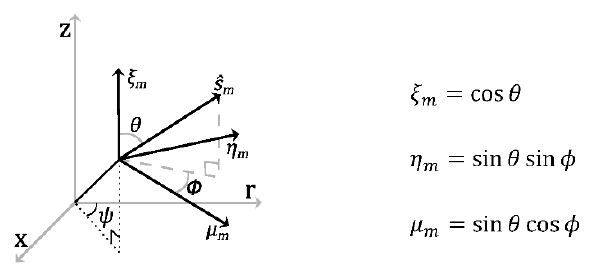
Figure 2. The direction cosines ( ξ m , η m and u m ) for the discrete direction ˆ s m , where θ and Φ are the polar and azimuthal angles, respectively, and ψ is a space variable in the azimuthal direction. The ordinates may be positive or negative with respect to the spatial coordinate system and a weight, w m , is related to each quadrature set of ordinates to cover the whole sphere of 4 π sr from a point according to Equation (3). The quadrature sets are further constructed in a way to be invariant if ◦ rotated 90 and are described more thoroughly by Fiveland